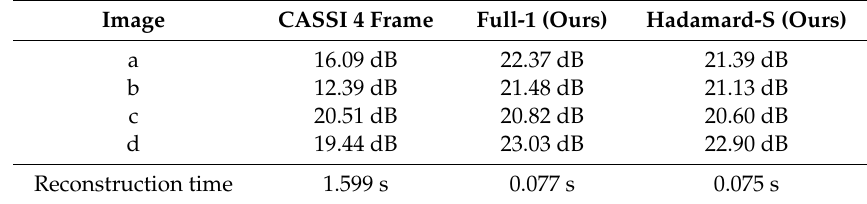
Figure 5. Reconstructed results of different methods. (The resolution of reconstructed image is 127 × 127) ( a ) Ground truth. ( b ) Reconstructed results of coded aperture snapshot spectral imager (CASSI) 4 Frame. ( c ) Reconstructed results of the full-1 matrix (our method). ( d ) results of Hadamard-S matrix (our method). Table 2. Comparison of peak signal-to-noise ratio (PSNR) and reconstruction time of different scenes.